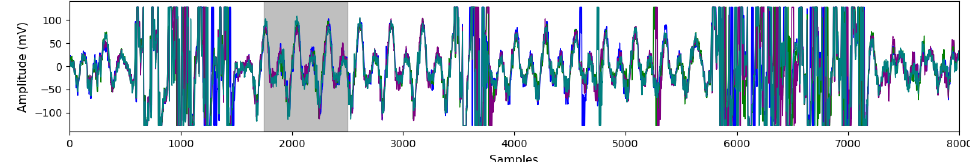
Figure 2: Arith-Cswap 4 overlapped traces (grey color marks aligned